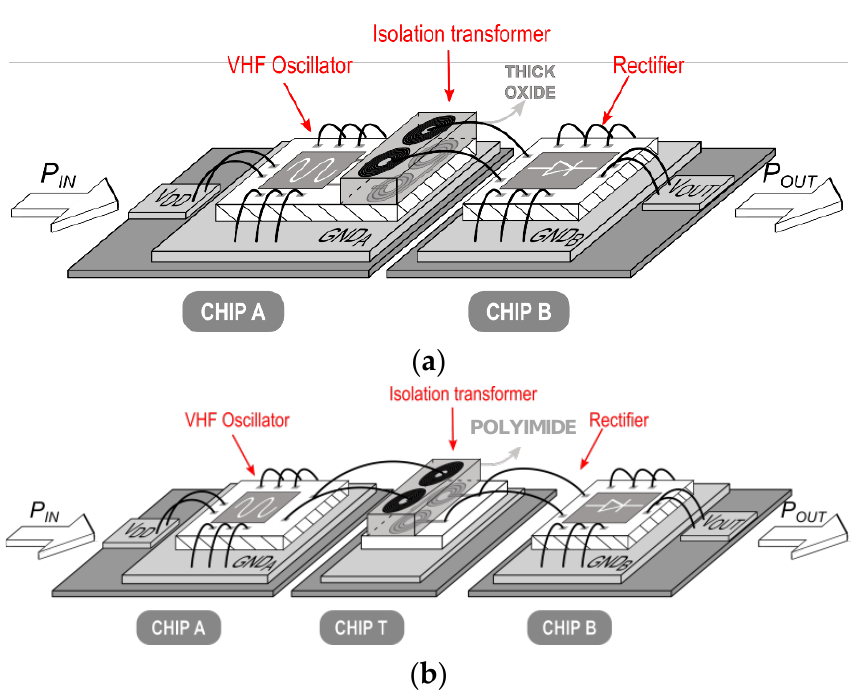
Figure 7. SiP implementation approaches: ( a ) integrated transformer; ( b ) standalone isolation transformer. Reproduced from [19]. Copyright 2018, Elsevier.